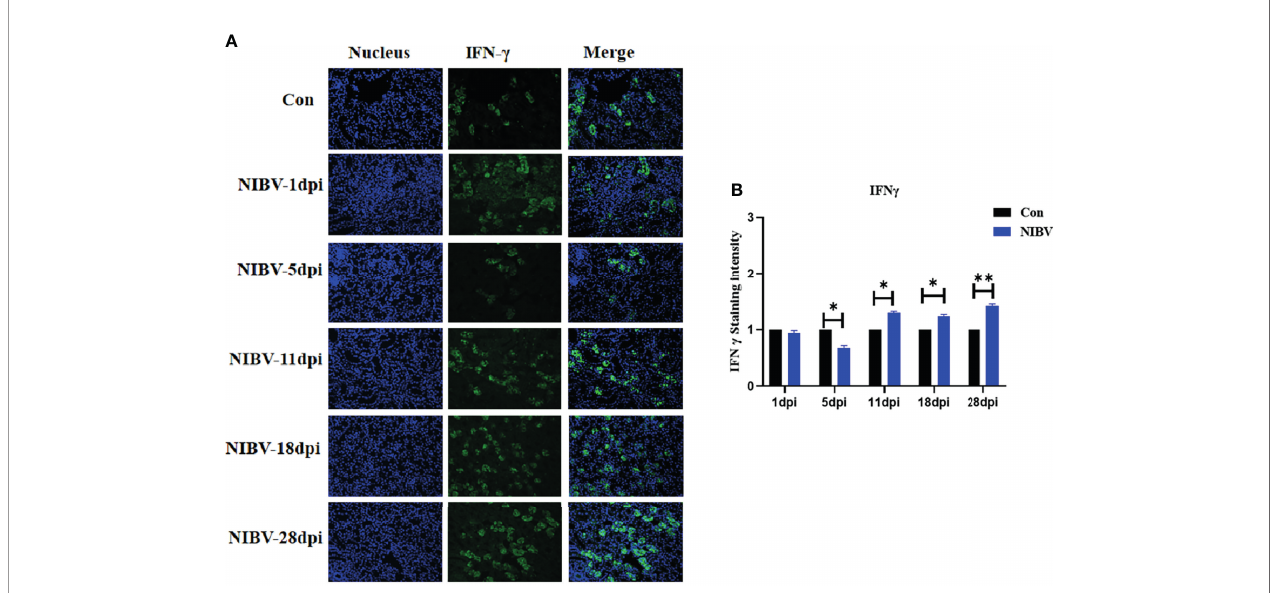
FIGURE 8 | Qualitative and quantitative immuno fl uorescence analysis of IFN- g proteins. (A) In this image, the nucleus staining is shown in blue, IFN- g staining is shown in green, and combined images show co-localization signal (400 total magni fi cation); (B) Mean IFN- g staining intensity in each group. Data are expressed as the mean SD, *(0.01 < P< 0.05), **(P < 0.01),